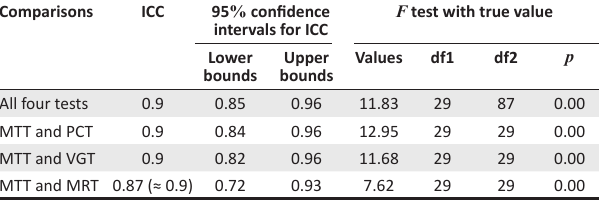
TABLE 5: Inter-rater correlation coefficients for modified Thorington test, prism cover test, Von Graefe test and Maddox rod test.